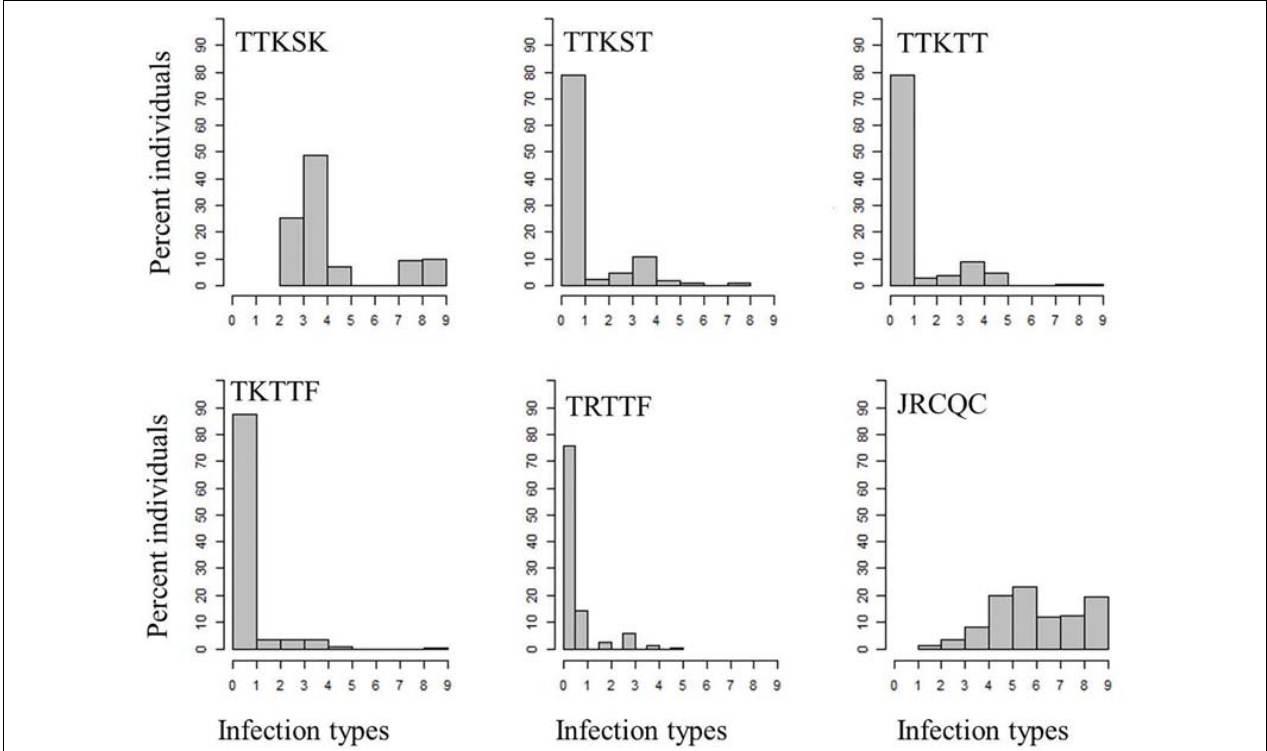
FIGURE 3 | Distributions of the seedling responses of the durum wheat genotypes to Puccinia graminis f. sp. tritici races TTKSK, TTKST, TTKTT, TKTTF, TRTTF, and JRCQC. X- axis corresponds to the linearized Stakman scale